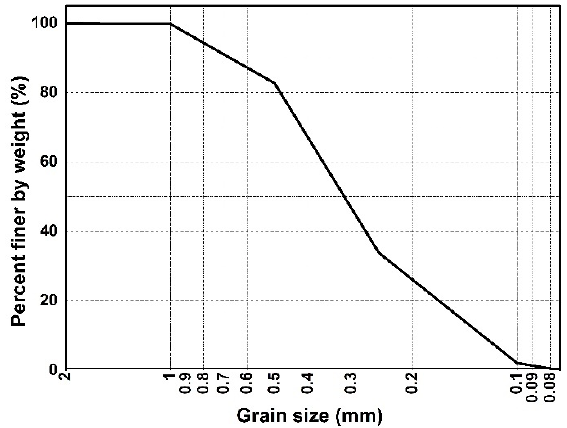
Figure 1. The particle size distribution curve of sand. Table 1. The detailed physical parameters of sand.